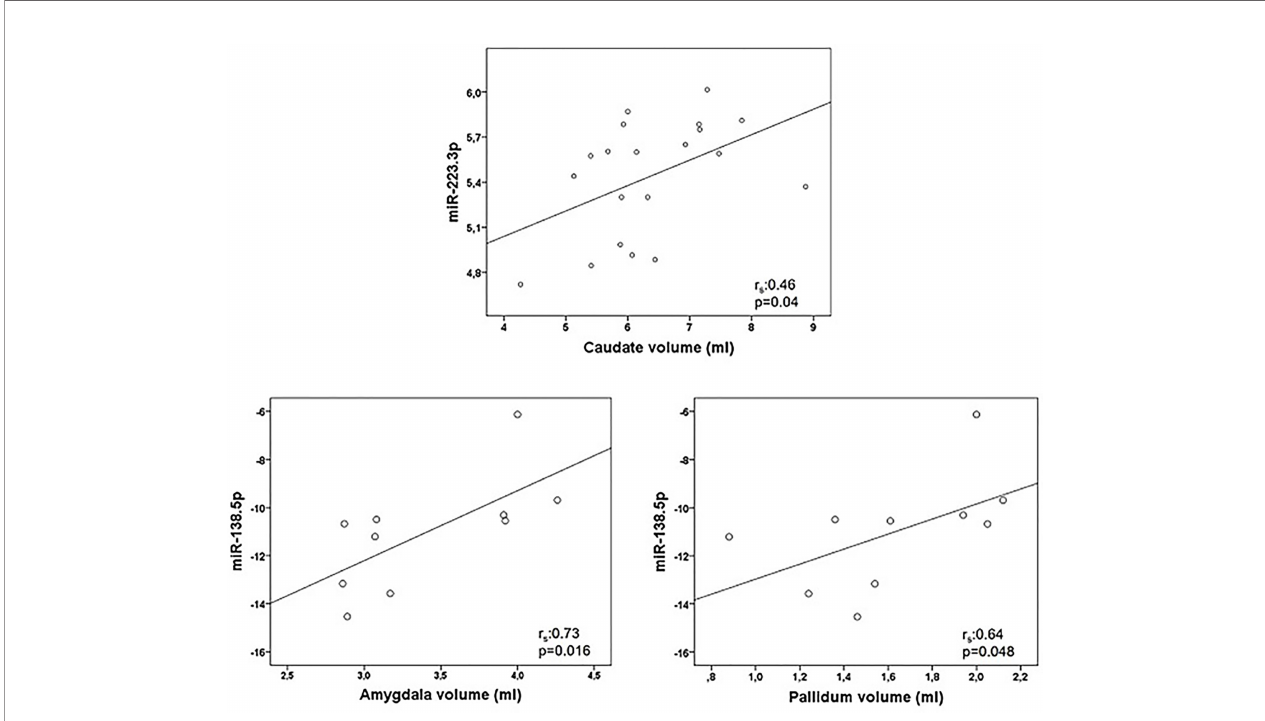
FIGURE 3 | Graphical representations of microRNAs (miRNAs) expression levels associated positively with magnetic resonance images (MRI) variables. MiR-223.3p was analyzed in 20 multiple sclerosis patients and miR-138.5p in 10 patients. Spearman correlation test was used for statistical analysis. r s : Spearman correlation coef fi